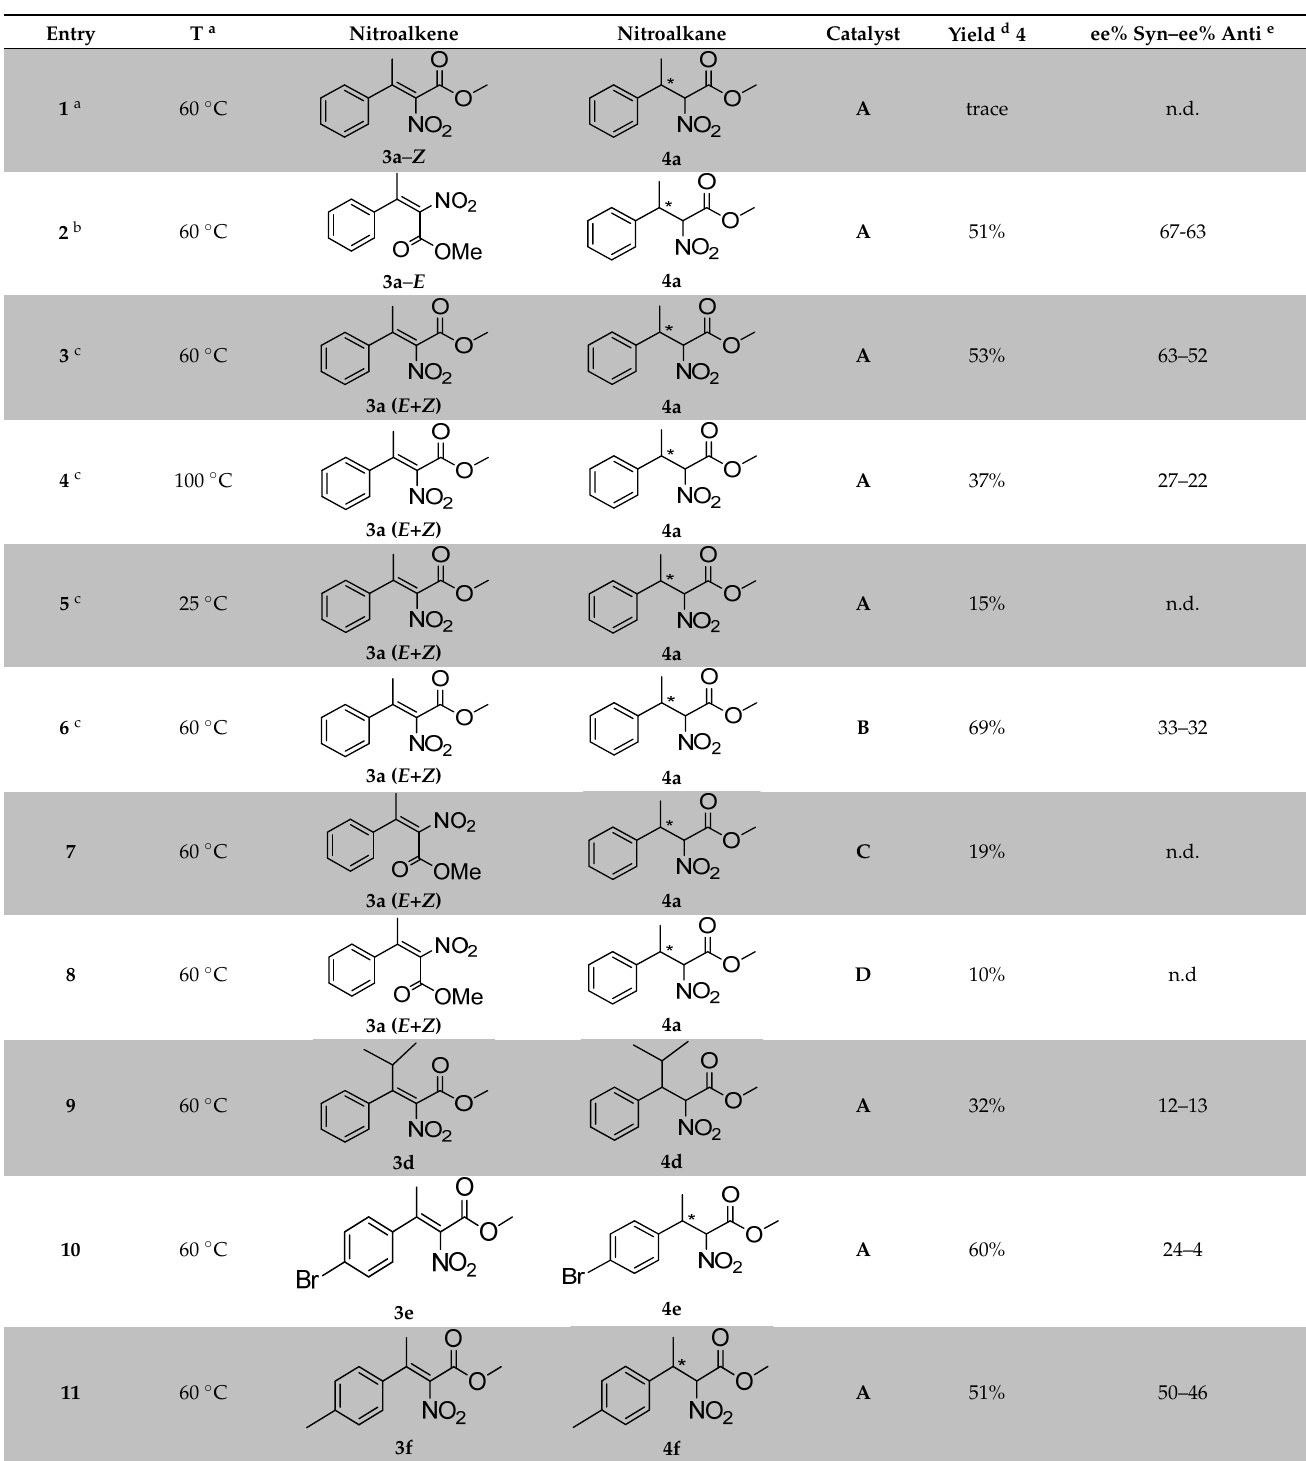
Table 3. Enantioselective reduction of tetrasubstituted nitroalkenes.